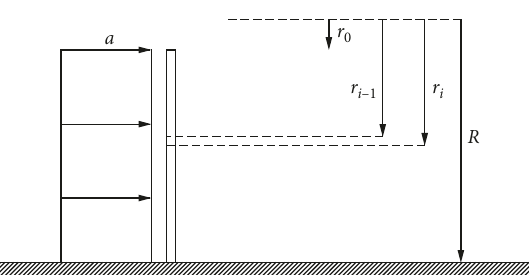
Figure 7: Conversion of the concentrated load S ∗ along the longitudinal direction of a